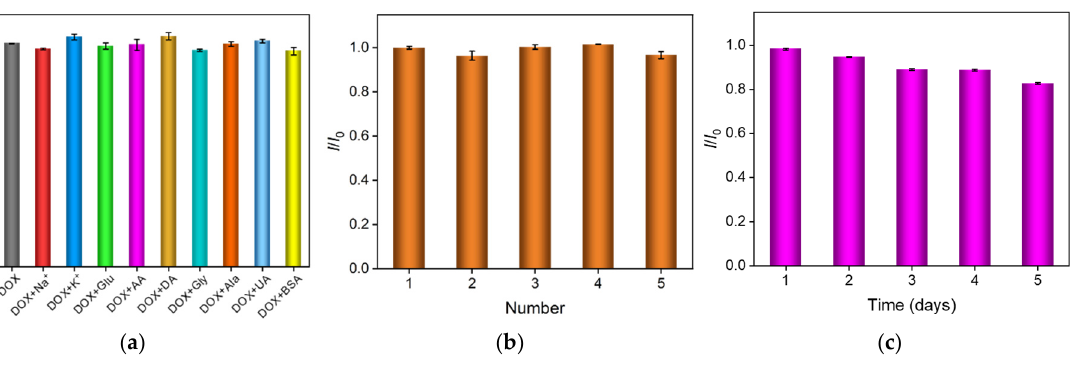
Figure 6. ( a ) The current ratio ( I / I 0 ) obtained from VMSF/ErGO/SPCE for the detection of 10 μ M DOX in the absence ( I 0 ) and presence ( I ) of added interfering species. The concentration of BSA is 0.4 mg/mL and the concentration of other interfering species are 1 mM; ( b ) The current ratio ( I / I 0 ) obtained from five parallel VMSF/ErGO/SPCE for detection of 10 μ M DOX— I 0 and I represent the signals of the first electrode and other electrodes, respectively; ( c ) The stability of VMSF/ErGO/SPCE in the detection of 10 μ M DOX for 5 days— I 0 and I mean the current measured on the first day and subsequent days.